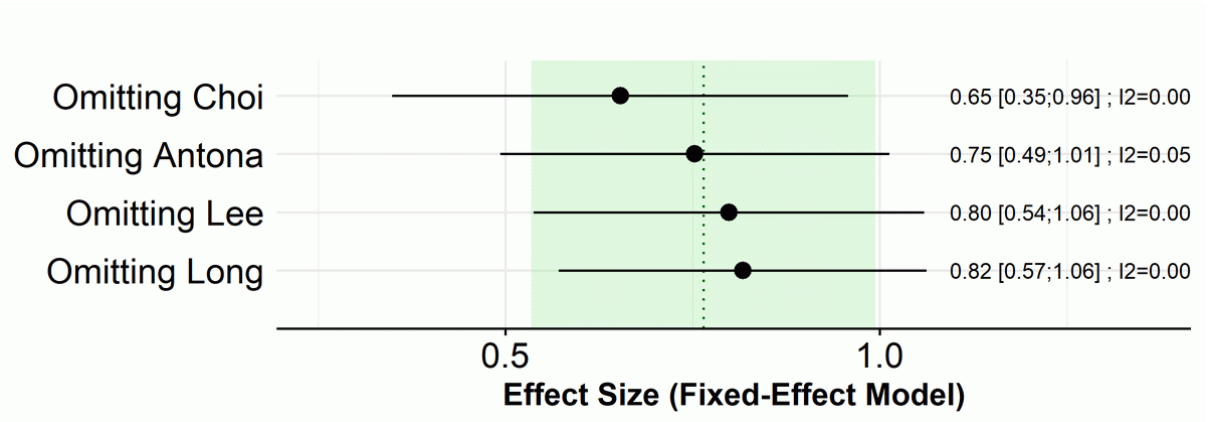
Figure 8. Pooled effect sizes (ESs) of visual function score in the smartphone overuse group compared to the reduced-use group from leave-one-out